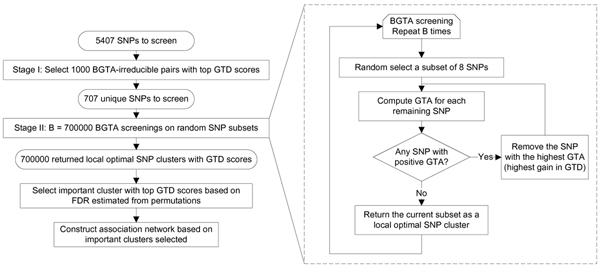
Flowchart for the analysis of the genome scan data.